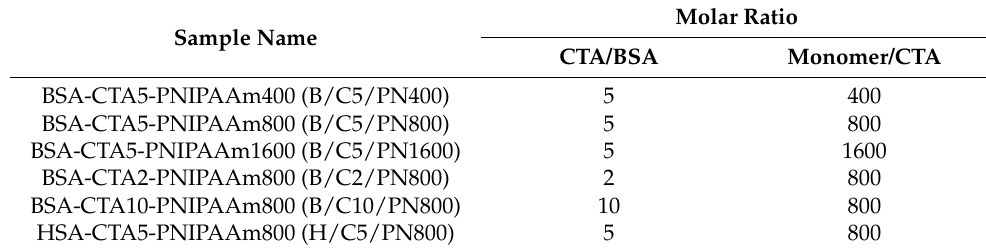
Table 2. Feeding ratios of BSA-PNIPAAm.